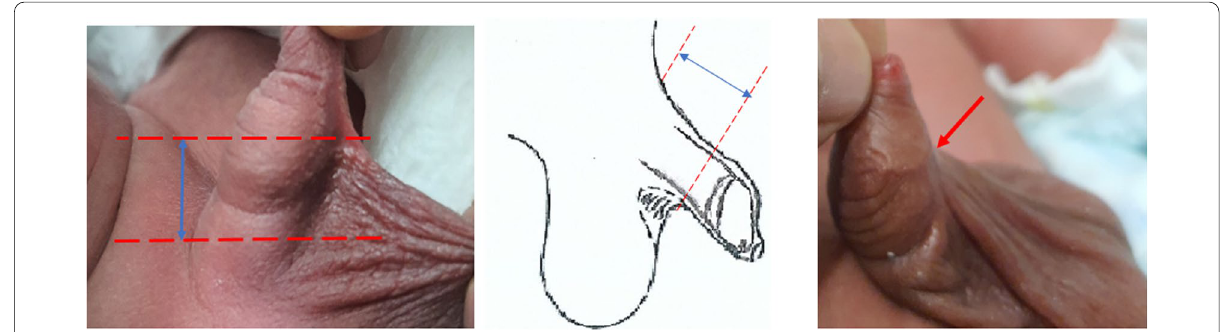
Fig. 4 Simple web penis demonstrates moderate penoscrotal